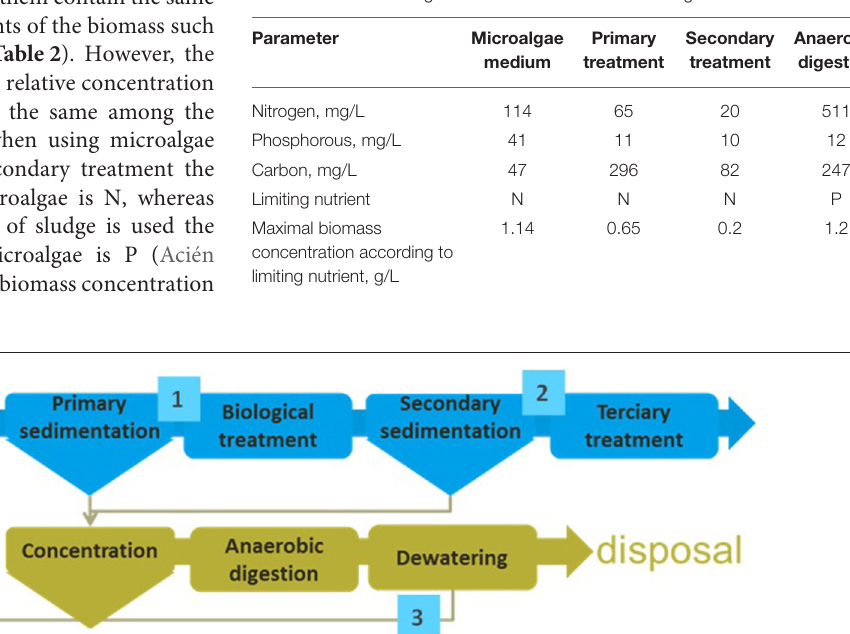
TABLE 2 | Composition of microalgae culture medium and effluents from wastewater treatment plants, nutrient limiting the production of microalgae biomass when using each one, and the maximal achievable biomass concentration according to the concentration of the limiting nutrient.